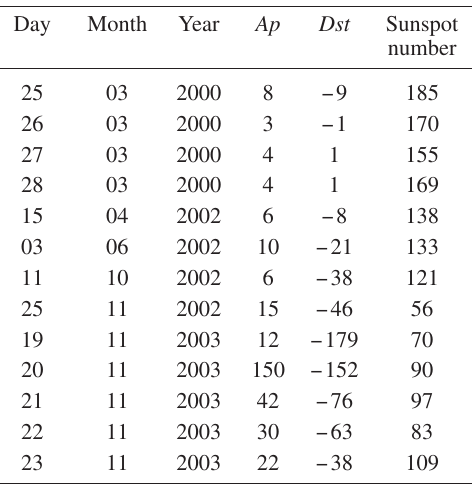
Table I. List of selected periods for the validation of the reconstruction method.